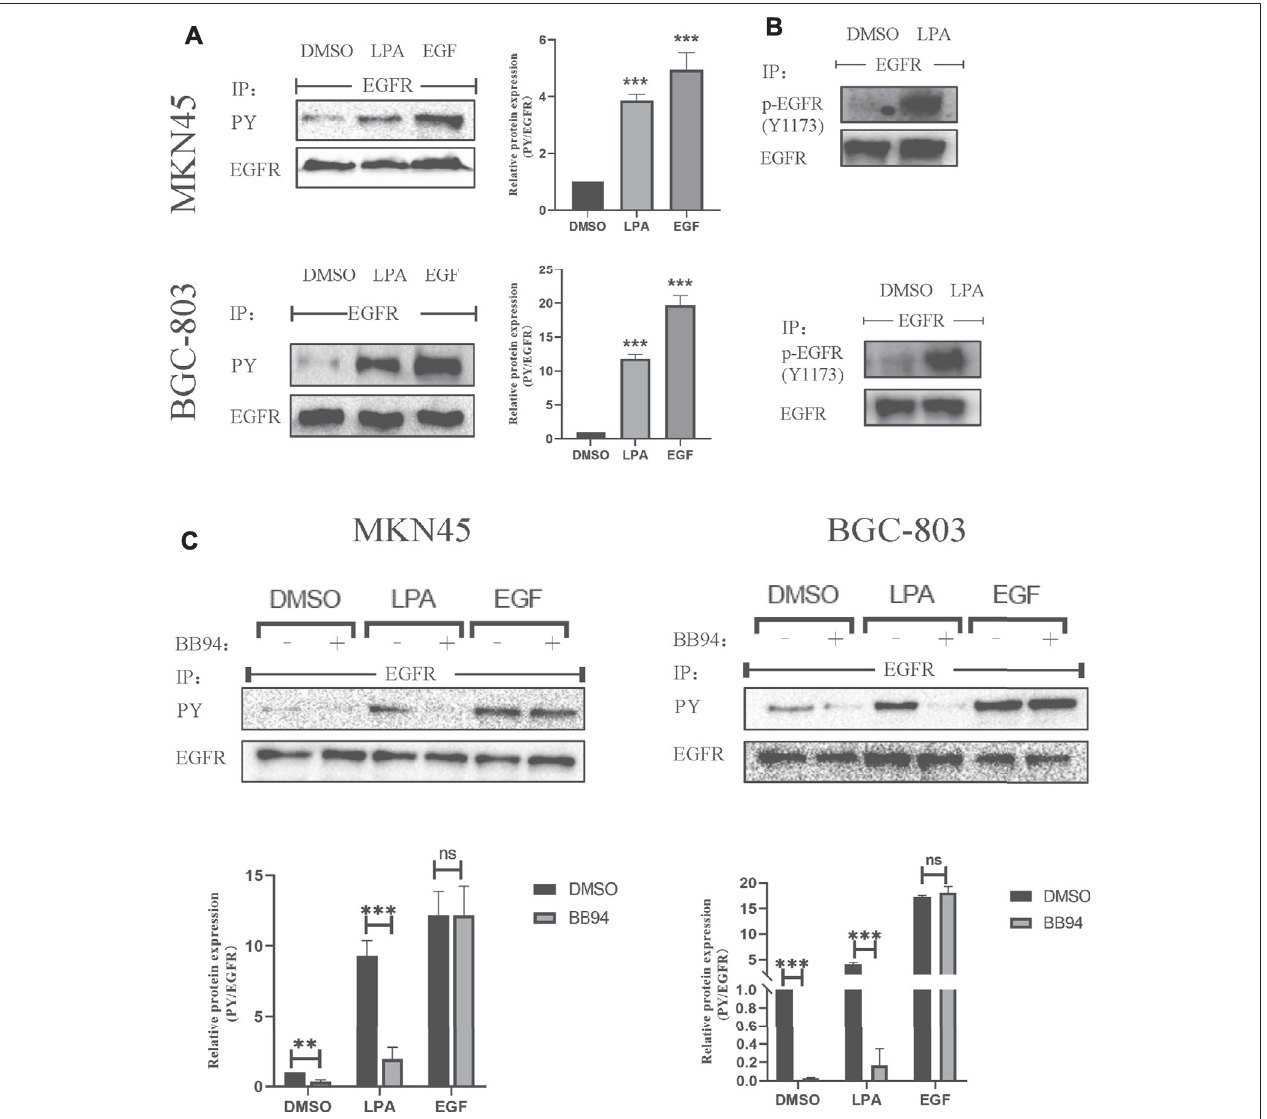
FIGURE5| LPAstimulatesEGFRtransactivationingastriccancercells. (A – B) Tyrosine-phosphorylatedEGFR( (A) ,PY)andY1173-phosphorylatedEGFR (B) level after treated with 0.1% DMSO (vehicle), 10 µM LPA, or 10 ng/ml EGF for 3 min. (C) Tyrosine-phosphorylated EGFR levels after pretreated with 0.1% DMSO or 10 µM BB94 for 30 min and stimulated with 10 µM LPA. Densitometry of three independent experiments was performed normalized to tubulin and expressed as a ratio of DMSO; mean ± SD, ** p < 0.01 (ANOVA test and Dunnette ’ s multiple comparisons test).